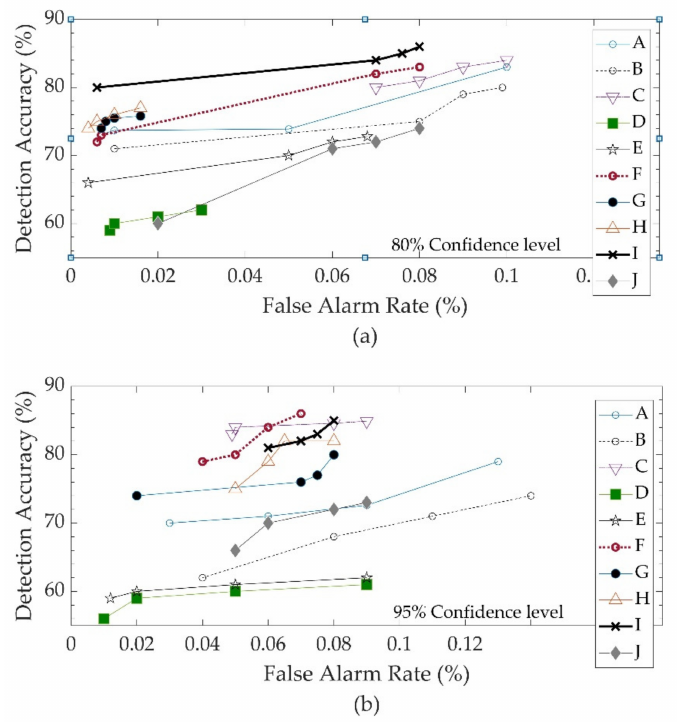
Figure 4. Relation between DA and FAR at 500 ft virtual segments and 100% market penetration: ( a ) 80% confidence level; ( b ) 95% confidence